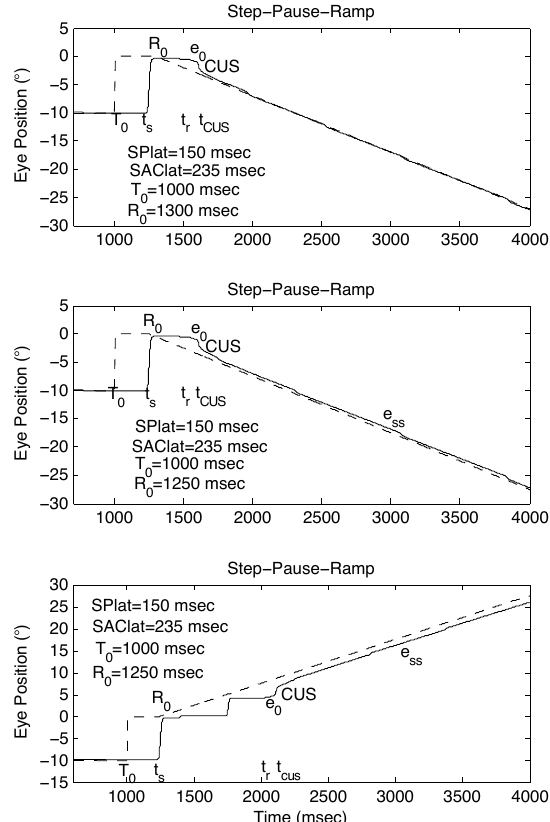
Figure 2. Examples of SPR stimuli, with R 0 set to be ap- proximately equal to t s , and simulated responses using the behavioral OMS model. (top) Expected response to SPR stimulus [SPR: -10°, 0°, -10°/sec @ 300 msec] if no saccade- pursuit interaction (e ss = 0). (middle) Possible response to SPR stimulus [SPR: -10°, 0°, -10°/sec @ 250 msec] if t CUS is approximately normal (small e ss ). (bottom) Possible response to SPR stimulus [SPR: -10°, 0°, 10°/sec @ 250 msec] if t CUS is >> normal (large e ss ). e ss = steady-state eye-position